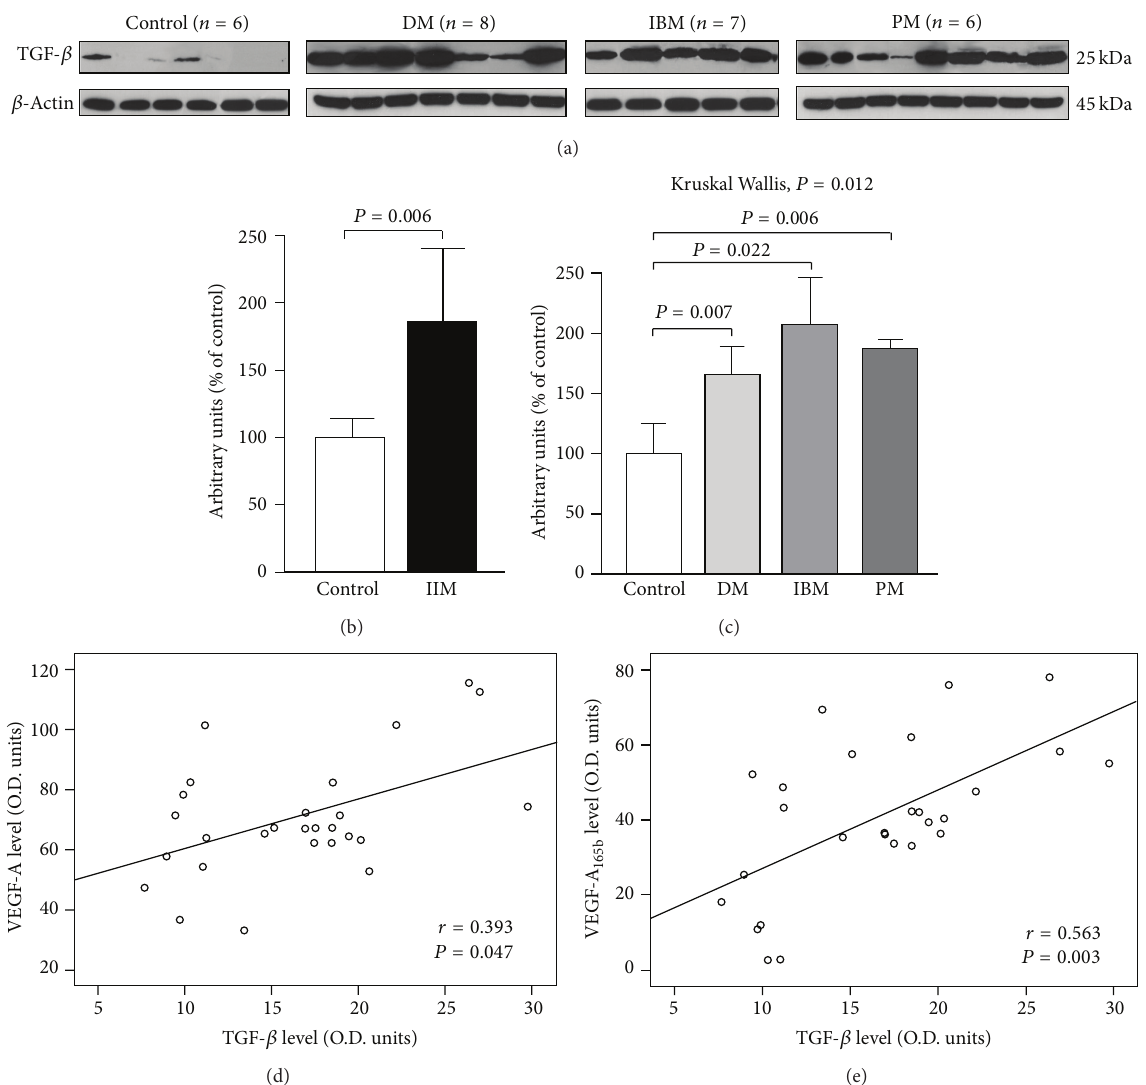
Figure 2: Increase of TGF- 𝛽 protein expression in inflammatory myopathies. Representative TGF- 𝛽 Western blots (a). Densitometric quantification of the TGF- 𝛽 bands was obtained by 𝛽 -actin normalization ((b), (c)). Histograms represent mean values ± SD from five independent experiments. All the statistical significant differences were reported. TGF- 𝛽 levels were in positive correlation with VEGF-A (d) and VEGF-A 165 b